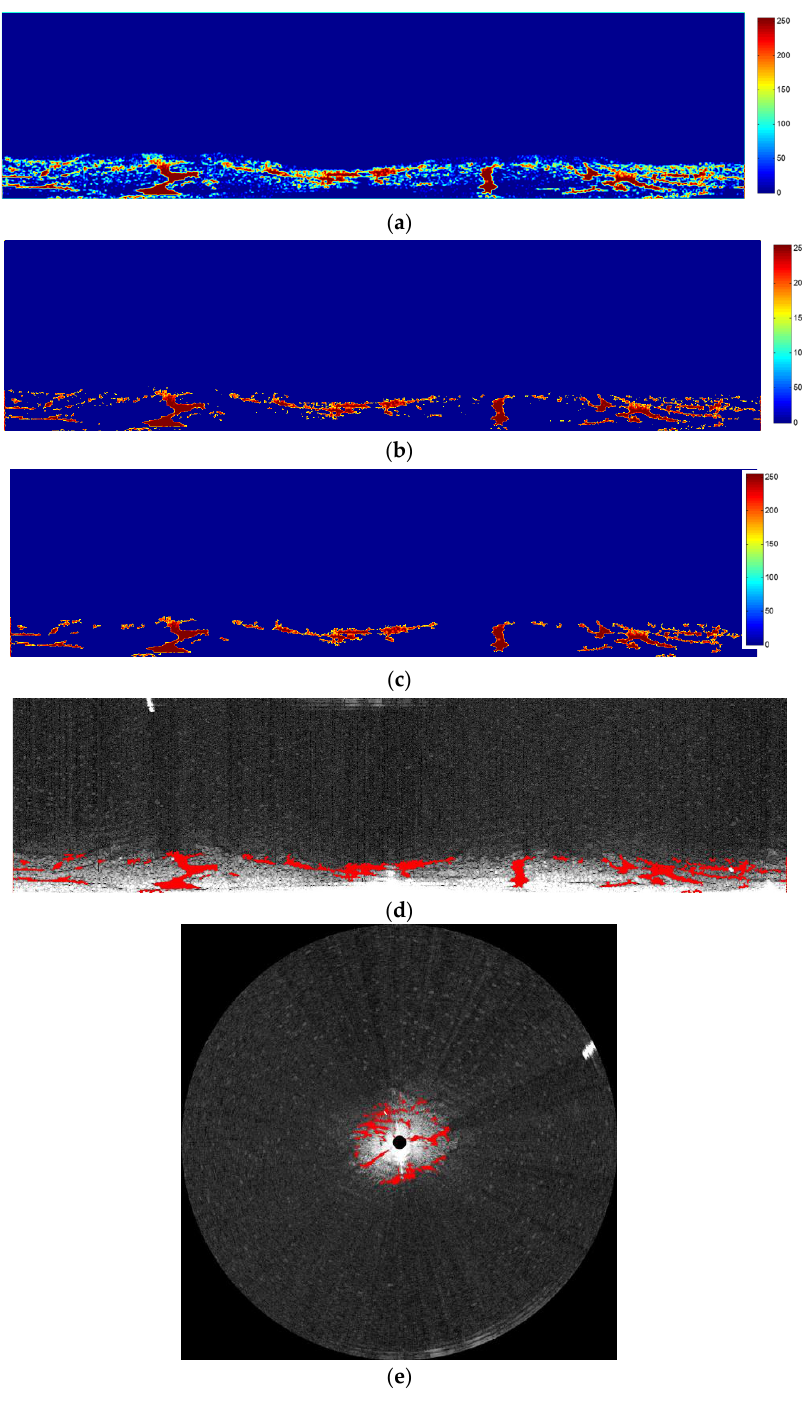
Figure 12. Oil spill segment based on improved adaptive thresholding: ( a ) overlapped image of an oil spill segment with five different strip thicknesses; ( b ) detected oil spill image with noise; ( c ) detected oil spill image with noise removed; ( d ) final processed radar image marked with the detected oil spill in the Cartesian coordinate system; and ( e ) the final processed radar image marked with the detected oil spill in the polar coordinate